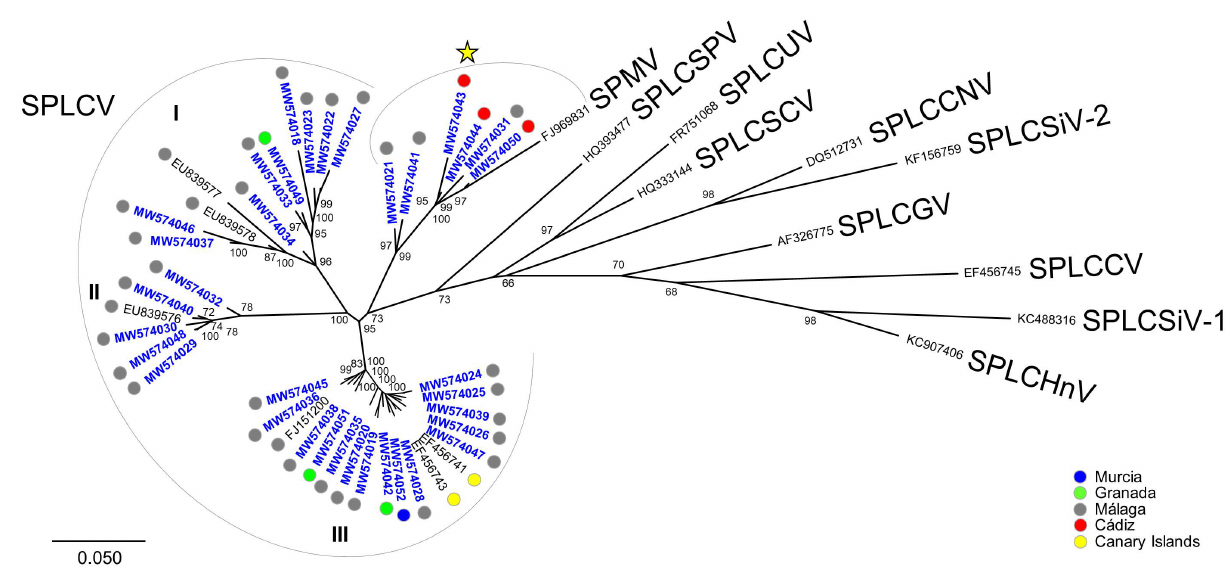
Figure 2. Phylogenetic tree illustrating the relationships of the sweepovirus genomes obtained in this work (highlighted in blue) with closely related sweet potato leaf curl virus (SPLCV) isolates previously reported from Spain and one representative isolate of all other sweepovirus species. Samples were obtained from Murcia (blue dots), Granada (green dots), M á laga (gray dots), and C á diz (red dots) provinces in southern continental Spain and the Canary Islands (yellow dots). I to III represent major SPLCV clades, and the yellow star corresponds to the clade including sweepovirus described in this work with an intermediate position between SPLCV and sweet potato mosaic virus isolates. The tree was constructed by the maximum likelihood method with the MEGA 7 program using the best fit model, GTR + G+I [31], and bootstrap values (1000 replicates) are shown for supported branches (>70%). The bar below the tree indicates 0.050 nucleotide substitutions per site. Additional details on the sequences and sweepovirus names are included in Tables S1 and